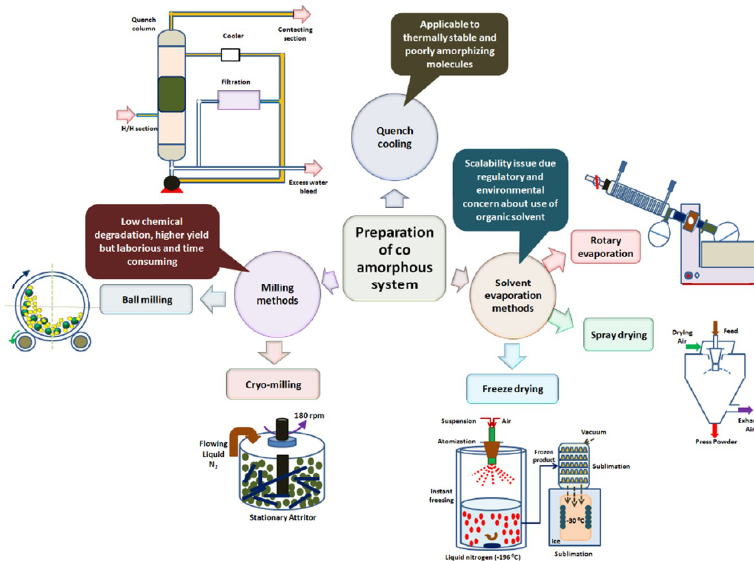
Figure 11. Preparation methods of co-amorphous systems [23].